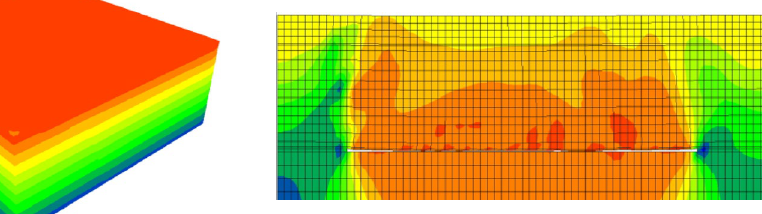
Fig. 7 Model stress equilibrium distributions